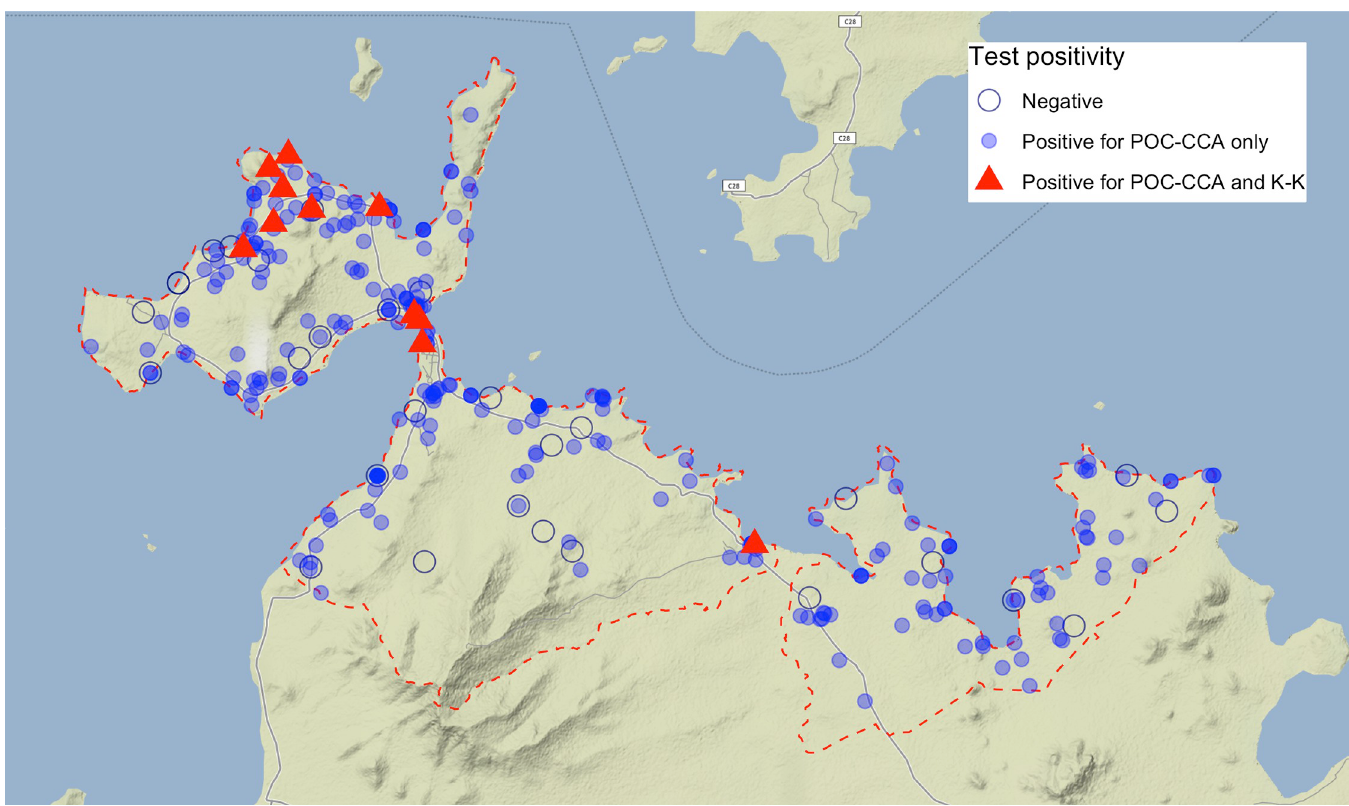
Fig 3. Spatial distribution of S . mansoni infection among children under two years of age in Mbita, Kenya.